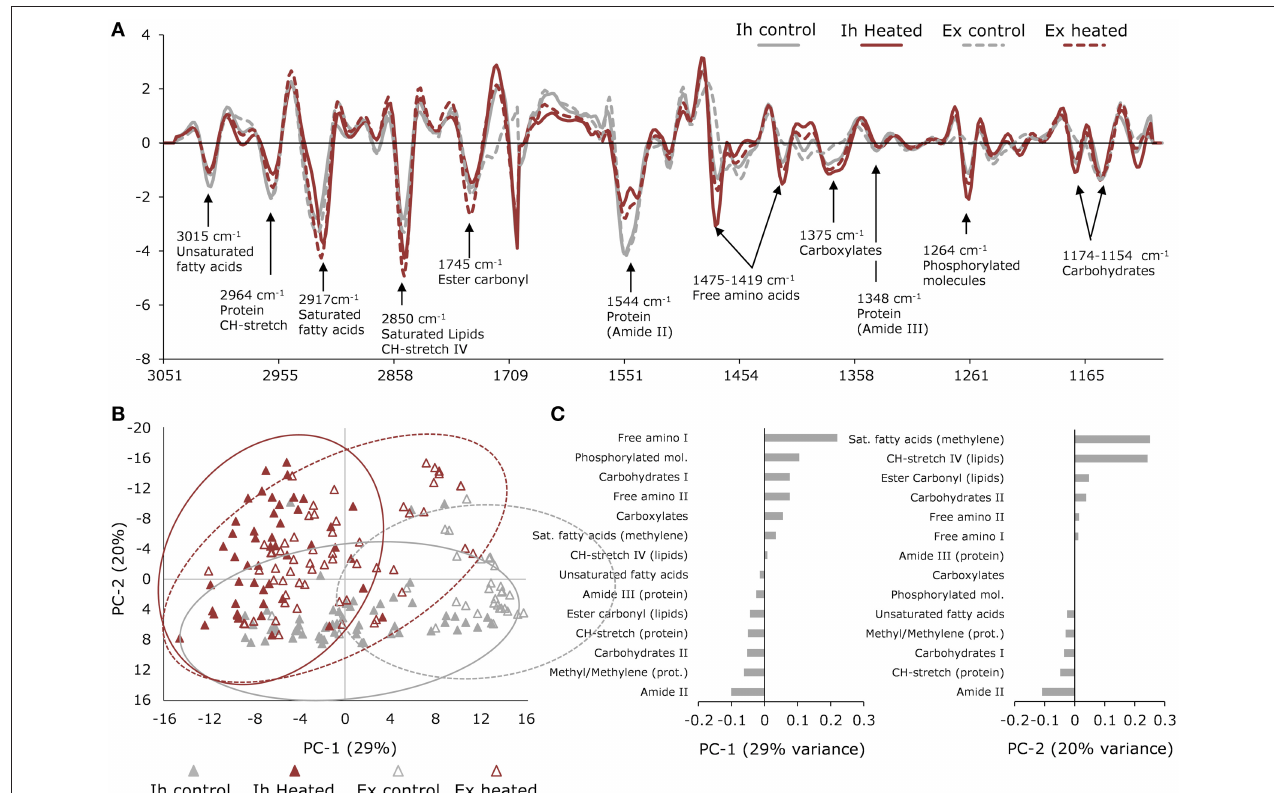
FIGURE 4 | Synchrotron-based IR microspectroscopy data. (A) Normalized average 2nd derivative spectra of in hospite (solid line) and expelled (broken line) cells from control (gray) and heated (red) corals showing major biomolecular peaks. (B) Principle Component Analysis (PCA) scores plot showing differentiation in macromolecular profiles of in hospite (closed triangles) and expelled (open triangles) cells under control (gray) and heated (red) conditions. Ellipses represent the 95% confidence intervals of the data. (C) PCA loadings showing the contributions of each biomolecule to PC1 and PC2 variation, where negatively loaded bands have the strongest absorbance in positively scored samples and positively loaded bands will have the strongest absorbance in negatively scored samples. Pre-treatment and sorting of spectra resulted in a total of n = 55 ( in hospite control); n = 48 ( in hospite heated); n = 29 (expelled control); n = 59 (expelled heated) collected across three individual coral colony